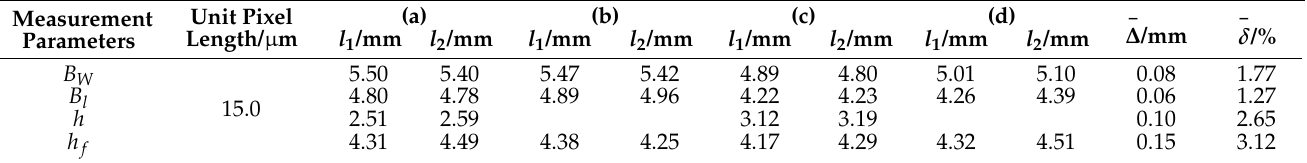
Figure 12. Line graph display of measurement results: ( a ) results of the weld, ( b ) results of the weld, ( c ) results of the weld, ( d ) results of the weld. Note : The weld height of ( b ) weld and ( d ) weld is replaced by 0. Table 5. Measurement results of the two